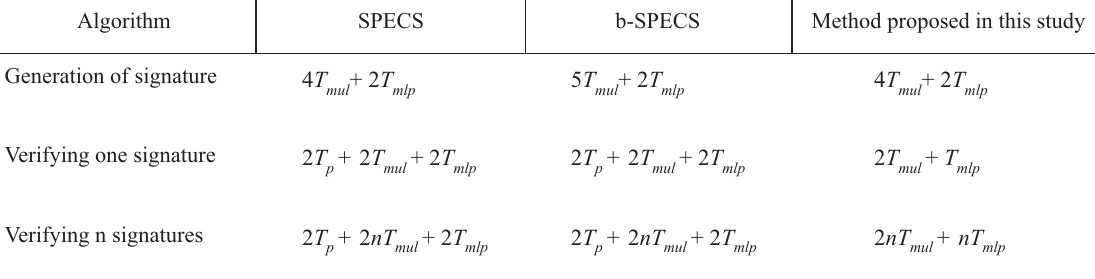
Table 2. Comparison of calculation time between different